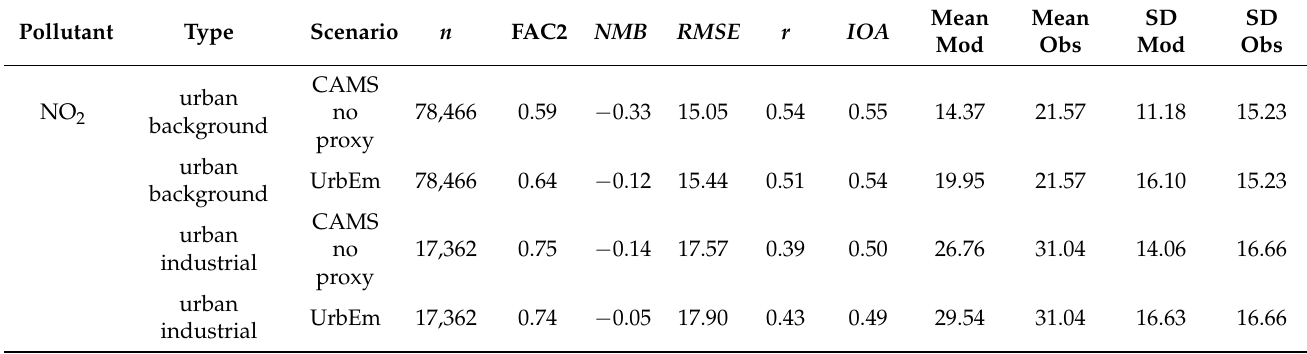
Table A2. Evaluation statistics for Hamburg. We aggregated all stations of the same type to groups of stations (type).